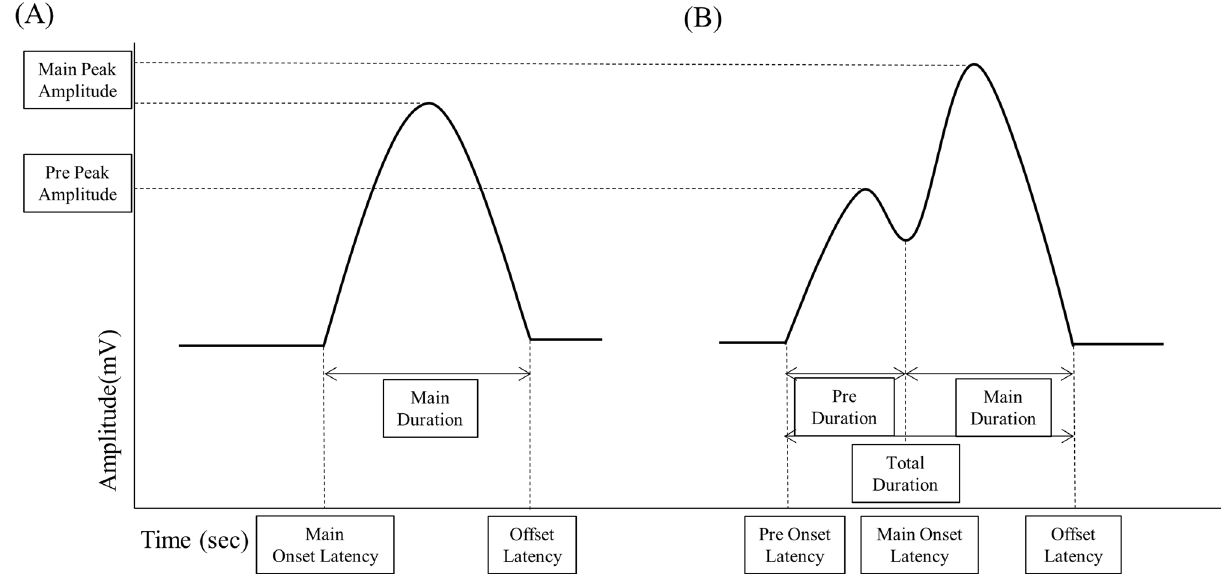
Figure 2. The two types of S-EMG activation patterns in the young and older groups. Type I pattern was characterized by a monophasic activation peak ( A ). Type II pattern was biphasic or triphasic, consisting of a pre- reflex peak and main peak ( B ).